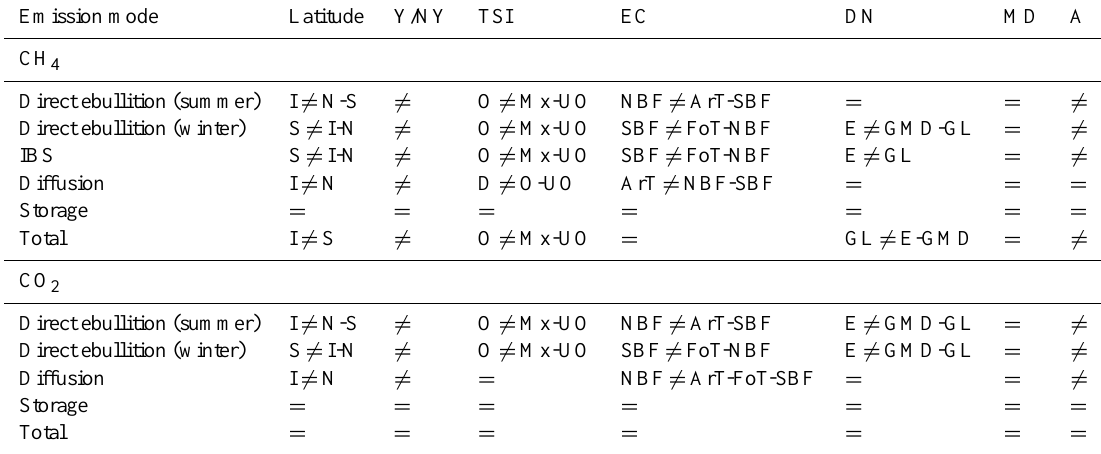
Table 3. The Mann–Whitney and Kruskal–Wallis test results of the limnological and geographic characteristics of lakes using CH 4 or CO 2 emission mode as the factor. “ (cid:54)= ” indicates a significant difference between limnological property or geographic characteristic vs. flux; “ = ” indicates no significant difference at Z value < 1.96. IBS – ice-bubble storage; Latitude: I – interior, N – northern, and S – southern according to Sect. 2.1; permafrost soil type (Y/NY – yedoma/non-yedoma); trophic state index (TSI), ecozonal categories (EC), and deposit type (DN) according to descriptions in Table 1; maximum depth known (MD) and area (A). In the MD analysis we considered two categories: shallow lakes ≤ 2.5m and deeper lakes > 2.5m. In the A analysis we considered two categories: small lakes ≤ 0.1km 2 and large lakes > 0.1km 2 . Emission mode Latitude